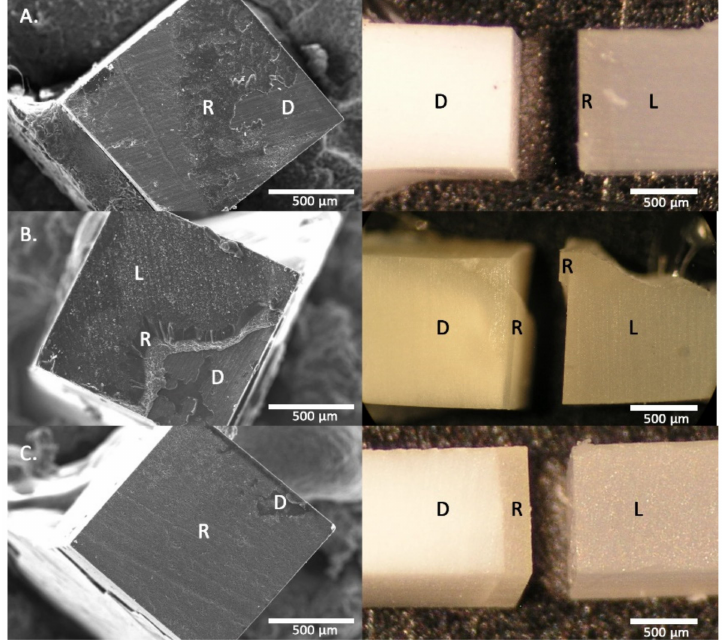
Figure 3. Representative images of the different types of failures as seen by scanning electron microscopy (SEM) ( left ) and stereomicroscope ( right ). ( A ) dentin/resin cement (DC); ( B ) Hybrid failure; ( C ) Lava™ Ultimate/resin cement (LC). R = resin cement; D = dentin; L = Lava™ Ultimate. Scale bar: 500 µ